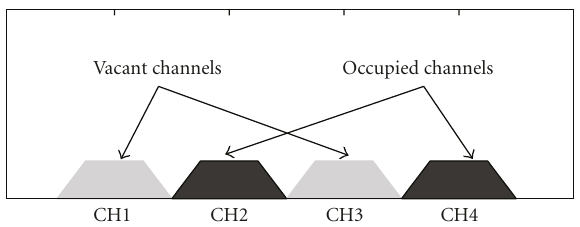
Figure 1: Timing synchronization for noncontiguous OFDM- based dynamic spectrum access poses challenges due to spectral limitation requirements, see, for example, [13, 14]. A user may decide to transmit in both vacant channels CH1 and CH3 without interfering with the user(s) in channels CH2 and CH4. More robust timing may be possible if the synchronization waveform is spread over both CH1 and CH3, which can be achieved without causing harmful interference to other user(s) by the pilot tone- based synchronization scheme investigated in this